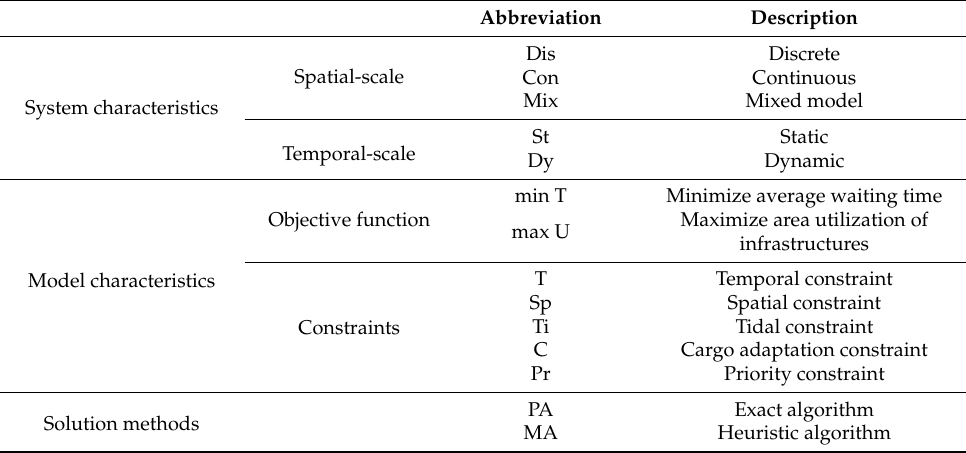
Table 1. Model evaluation and classification